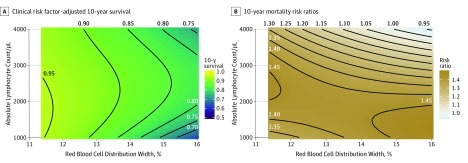
Mortality Risk According to Multiple-Parameter Immunohematologic StatusMultivariable Cox proportional hazards regression models were used to depict the 10-year survival proportion of an individual aged 60 years as a function of traditional clinical risk factors as well as absolute lymphocyte count (ALC), red blood cell distribution width (RDW), and C-reactive protein (CRP) level. Contours are shown according to immunohematologic variables adjusted to represent median values of continuous covariates (systolic blood pressure: 122 mm Hg; diastolic blood pressure: 70 mm Hg; total cholesterol level: 197 mg/dL; high-density lipoprotein cholesterol level: 50 mg/dL [to convert cholesterol to millimoles per liter, multiply by 0.0259]) as well as the discrete variables of female sex, nonsmoking, no diabetes, non-Hispanic ethnicity, and white race. A, Contours of clinical risk factor–adjusted 10-year survival are shown according to RDW and ALC, centered for a CRP level of 0.5 mg/L (to convert to nanomoles per liter, multiply by 9.524). Similar survival contours are observed for other CRP levels and/or participants centered at 80 years of age as shown in eFigure 5 in the Supplement. B, Model estimates of 10-year mortality risk ratios comparing different levels of CRP (0.5 mg/L vs 0.1 mg/L) for an individual aged 60 years across the continuum of ALC and RDW. Similar survival contours are observed for participants centered at 80 years of age and for a comparison of CRP levels of 1.0 vs 0.5 mg/L as shown in eFigure 6 in the Supplement. To convert ALC to ×109 per liter, multiply by 0.001.